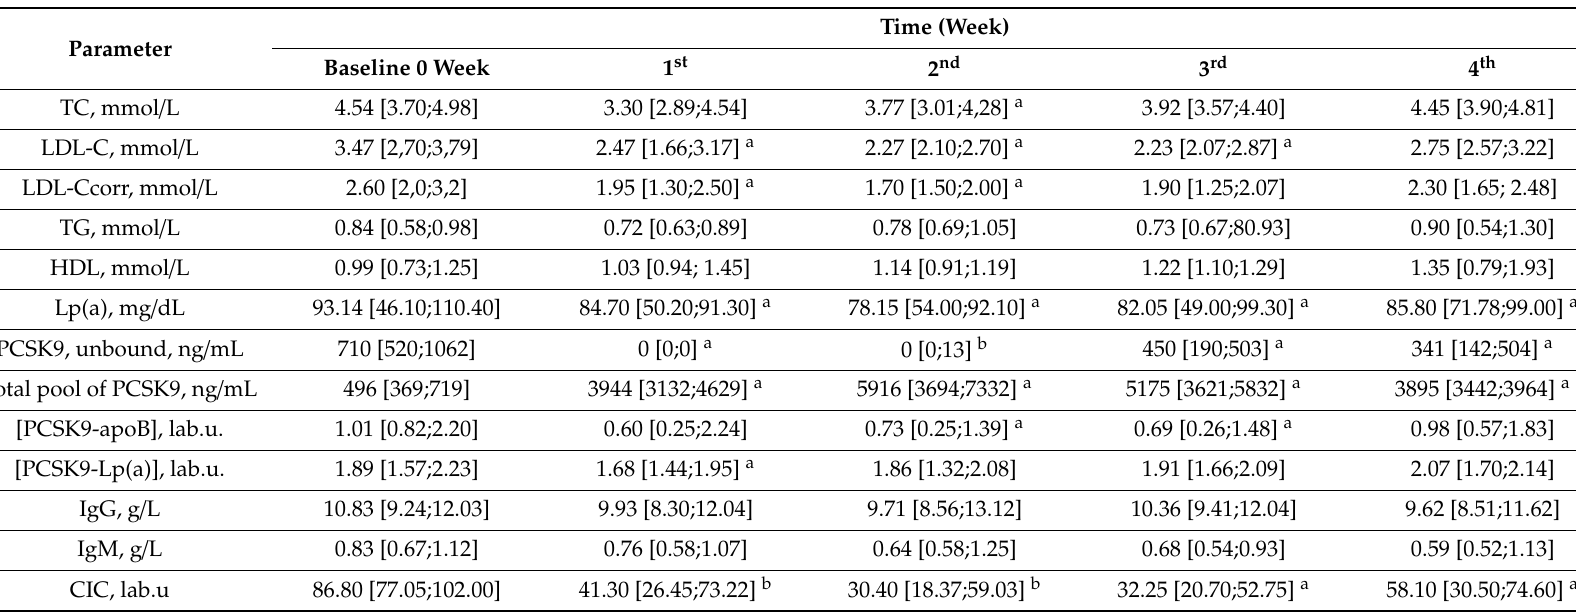
Table 1. Changes in serum lipids, Lp(a), unbound PCSK9, and circulating complexes of PCSK9 with lipoproteins and immunoglobulins during the 4 weeks after a single injection of Evolocumab 140